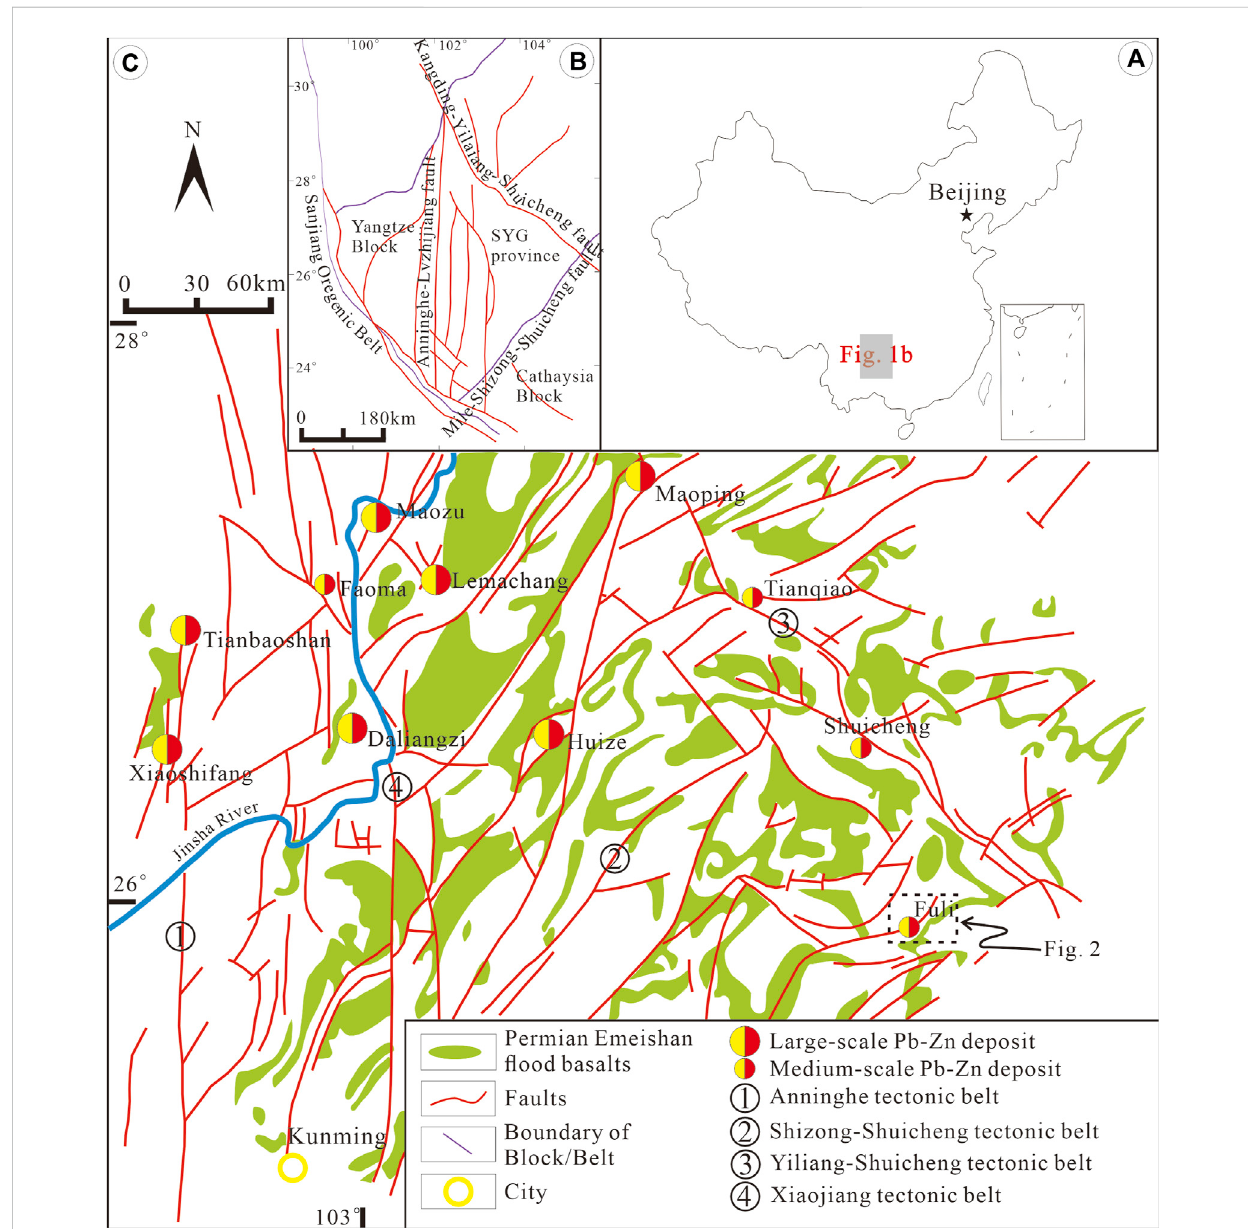
FIGURE 1 (A) A map showing the location of the SYG metallogenic province. (B) Geological framework of Southwestern China. (C) Geological map showing the distribution of the Pb-Zn deposits and Emeishan Flood basalt of the SYG metallogenic province, and the location of the Fuli deposit in the